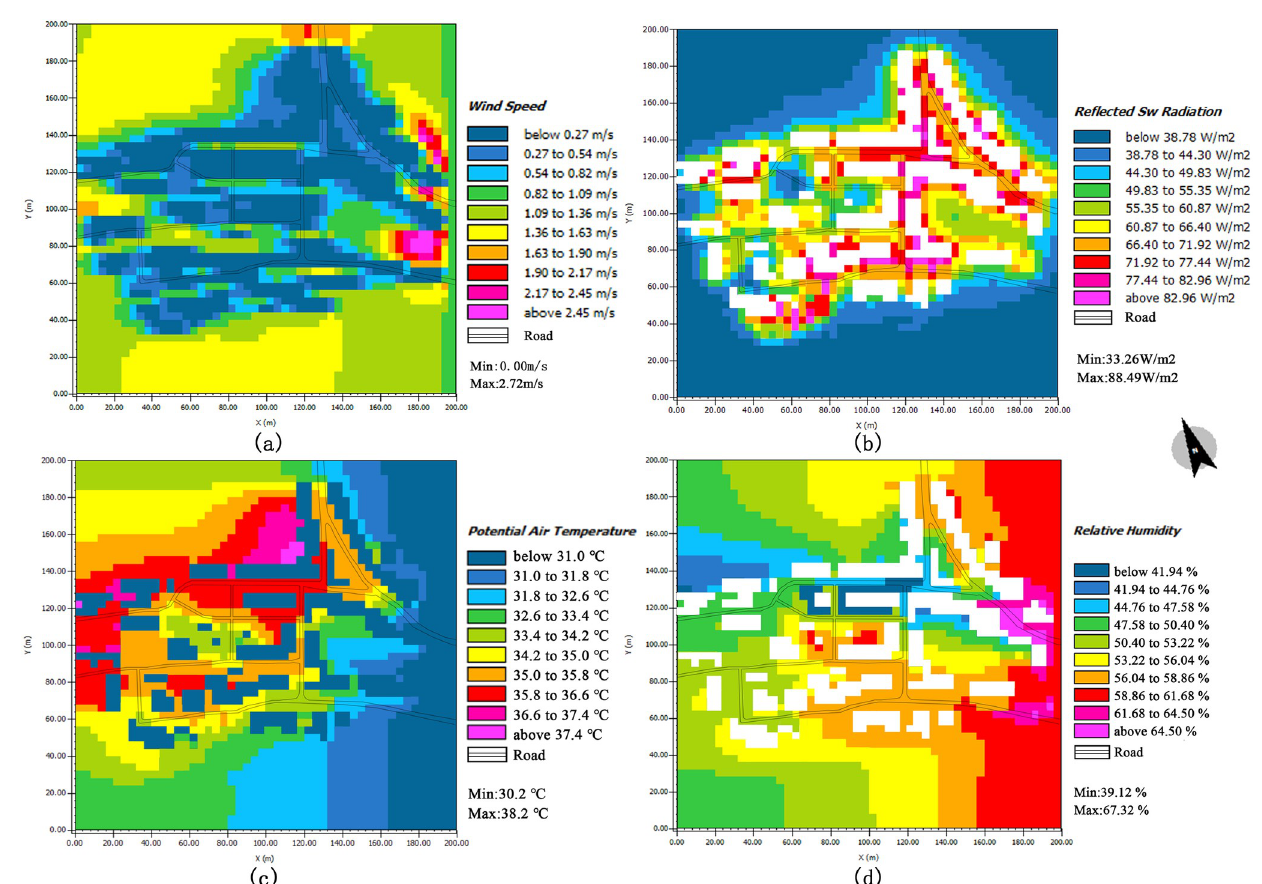
Fig 17. Simulation results of the thermal